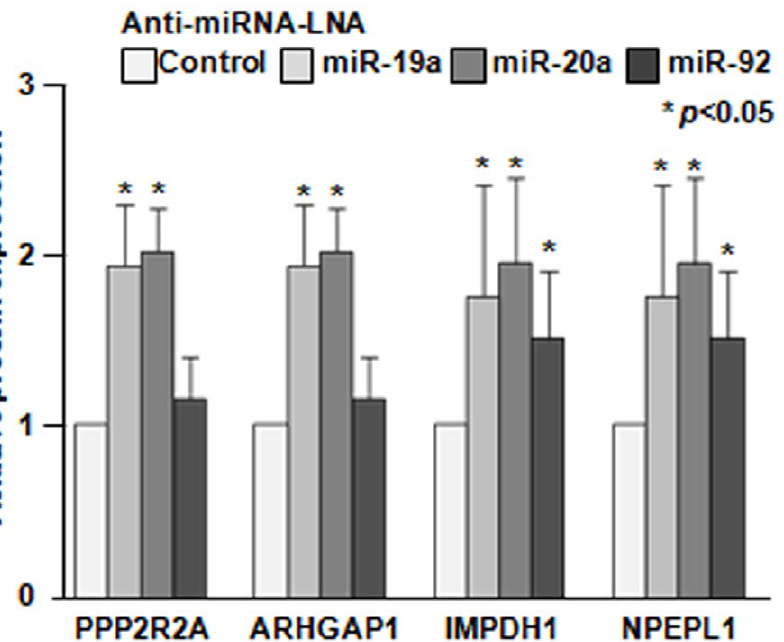
Figure 3. The relative expression levels of candidate proteins. The differentially expressed proteins from MCF-7 cells treated with anti- miRNA-LNAs compared to those treated with the control-LNA were identified and analyzed using the PDQuest Advanced Ver.8.0 software program (Bio-Rad), on the basis of their fluorescence intensity. *, p , 0.05; **, p , 0.01 using a two-tailed t -test (miRNA-LNA treated vs. control-LNA treated).